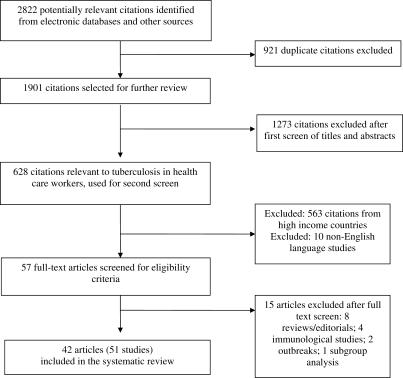
Study Flow Chart